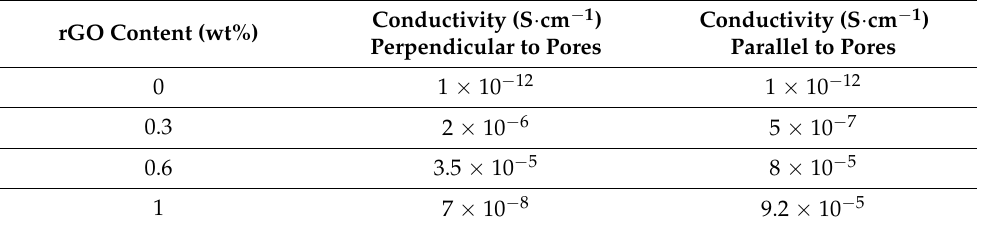
Table 1. Electrical conductivity of PLCL/rGO scaffolds in the direction perpendicular to the pores and in the parallel direction.